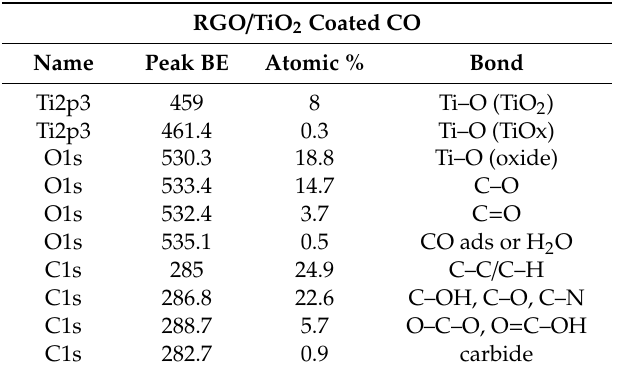
Table 2. Deconvoluted XPS data of coated fabrics (A smart-type background subtraction model was used to obtain the XPS signal intensity of each individual peaks. Subsequently, an asymmetric Gaussian / Lorentzian function at a constant ratio G / L = 0.35 was used for the deconvolution procedure. All measured BEs were calibrated to the position of C 1s peak at 285.0 eV). RGO / TiO 2 Coated